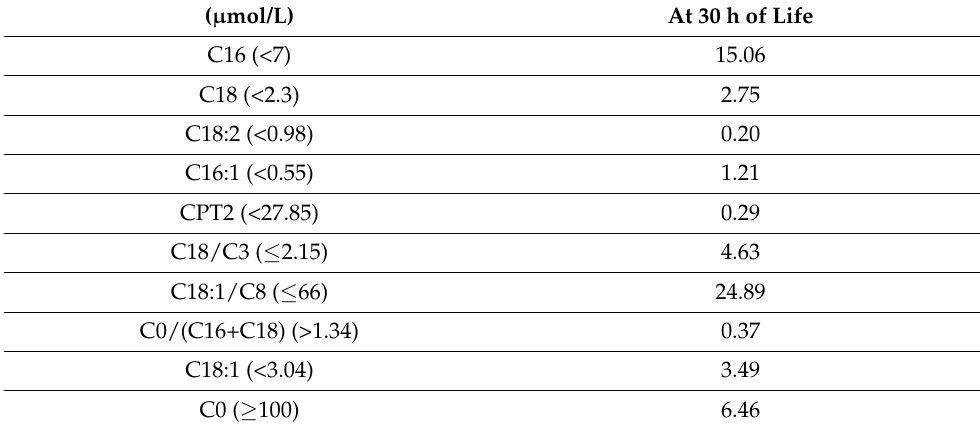
Table 2. Newborn Screening Result of Baby